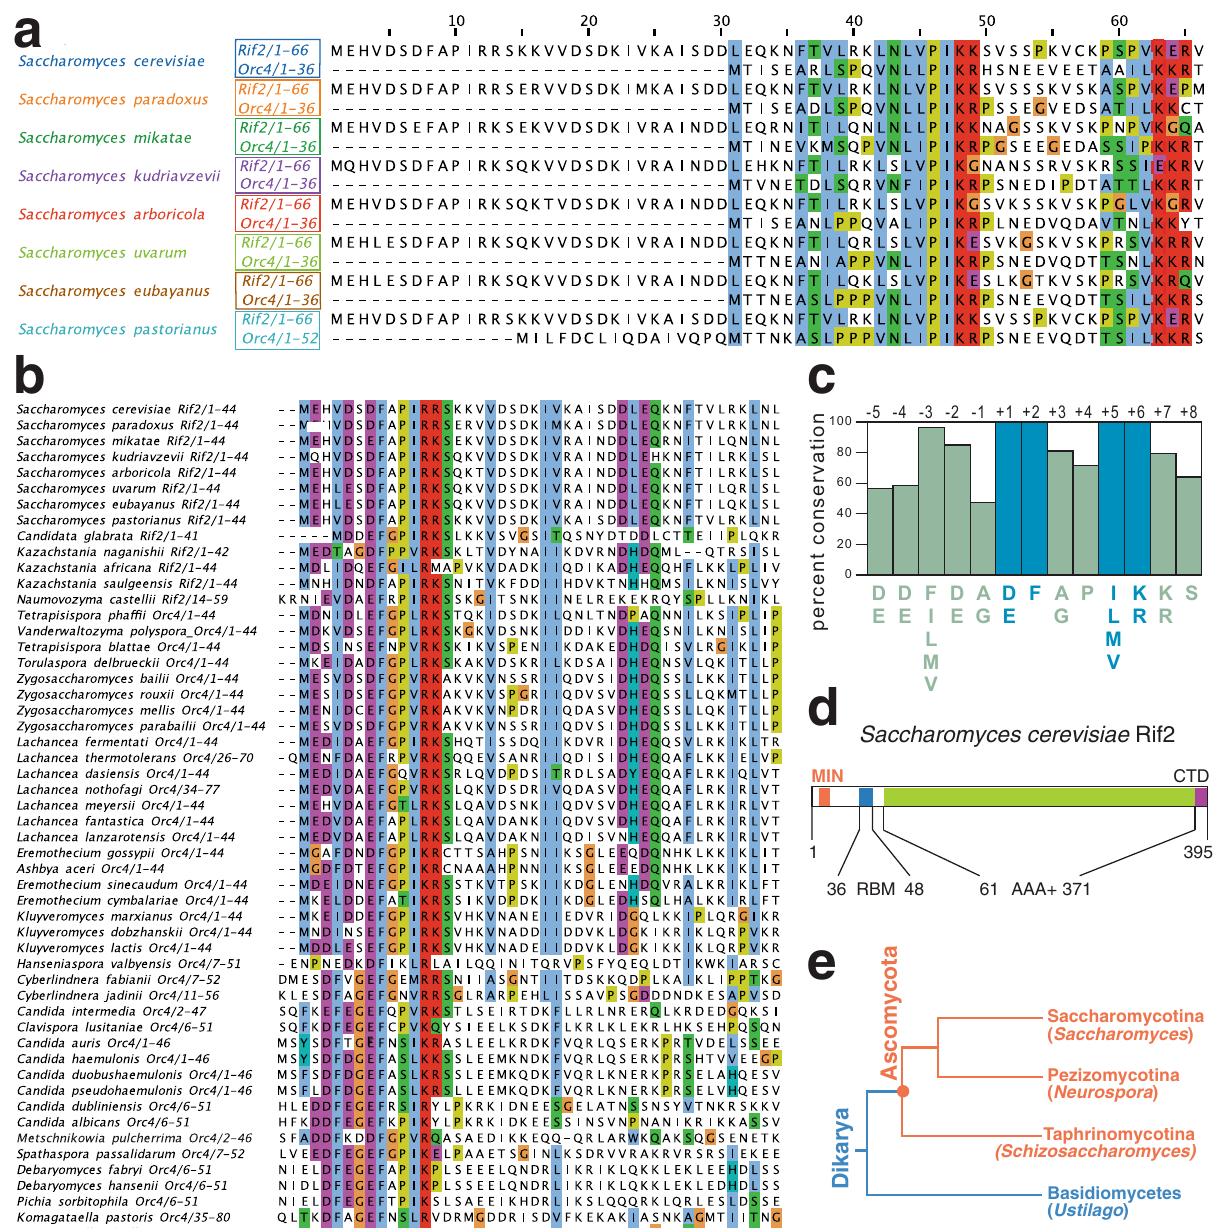
Fig. 1 A conserved protein motif at the N terminus of Rif2 and Orc4 in the Saccharomycotina. a Sequence alignments of the indicated Rif2 and Orc4 proteins from Saccharomycotina species where Rif2 is present were produced in Clustal Omega and gaps were manually eliminated. Amino acid included are indicated after the protein name. Alignments were done using the Clustal Omega interface on the EBI site. Alignments were edited (in this case) and imaged in Jailview using Clustalx colouring of conserved residues (panels a , b and Fig. 7a). b Sequence analysis as in ( a ) of Rif2 and Orc4 N-terminal regions from species where the conserved region identi fi ed in the N-terminal extension in ( a ) is present. Species are broadly arranged top to bottom according to the phylogeny described in ref. 74 . c Diagram illustrating the prevalence of conserved residues in the N-terminal cluster derived from the alignment in ( b ), de fi ning the MIN motif. Based on the presence of four invariant residues (see also Fig. 7b) we adopt for the motif the numbering indicated on top of the diagram (invariant positions at + 1, + 2, + 5 and + 6, in blue). d Diagram of the domain structure of budding yeast Rif2. Conserved domains previously identi fi ed in ScRif2 include an AAA + fold shared with Orc4, and a Rap1-binding motif (RBM) at the N terminus and one (CTD, C-terminal domain) at the C terminus 61 ; the position of the MIN motif is shown in orange. e Phylogenetic tree, showing the relationship among the three clades comprising the Ascomycota. Representative species are indicated within parenthesis. Adapted from ref. 75